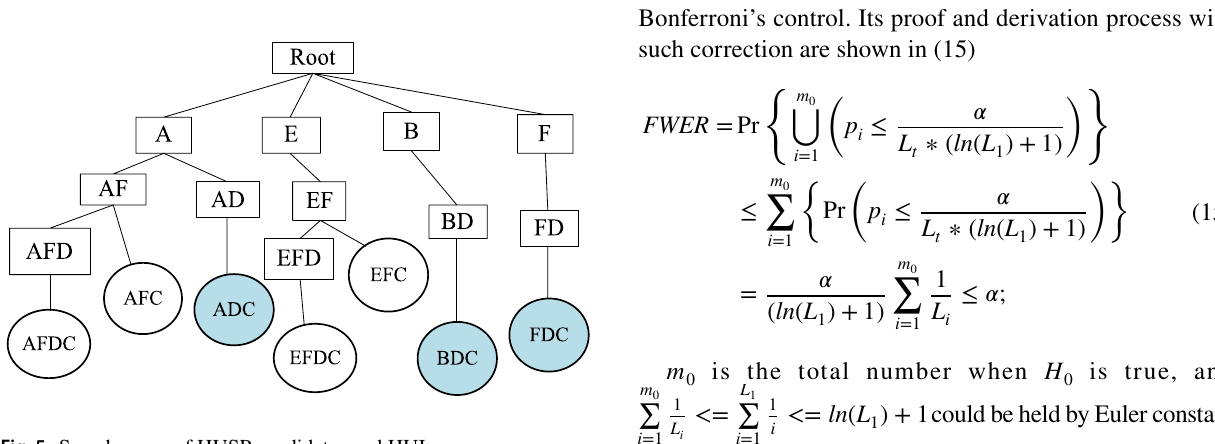
Fig. 5 Search space of HUSP candidates and